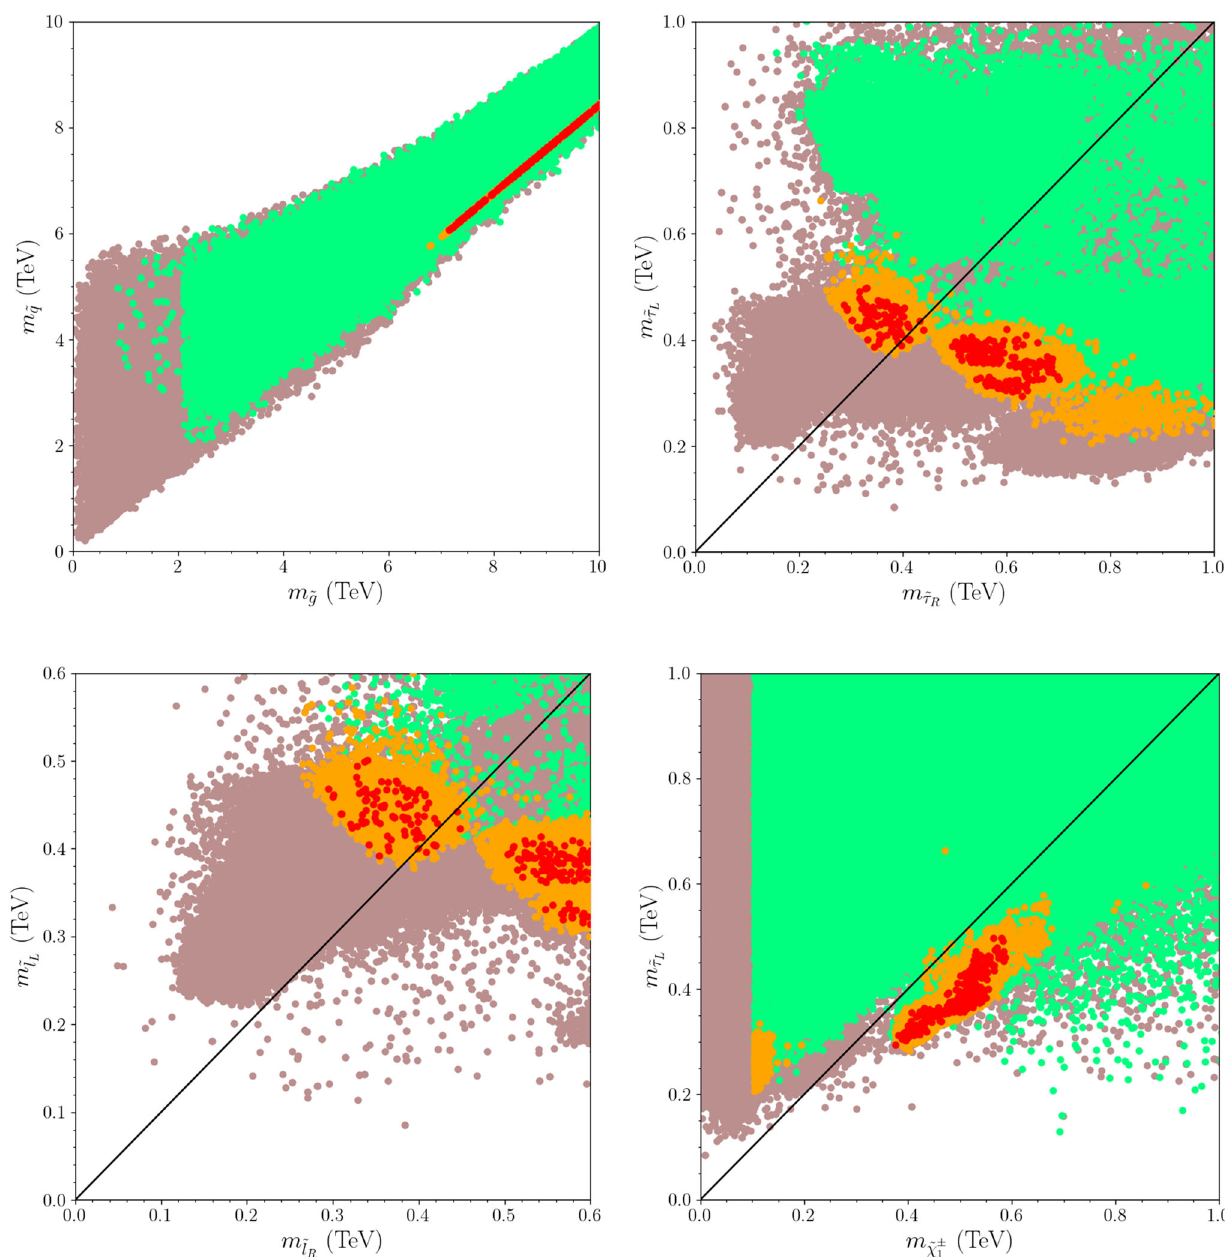
− m ˜ τ − m ˜ μ − m Fig. 7 Sparticle spectrum with plots in the m ˜ q − m ˜ g , m ˜ τ , m ˜ μ and m ˜ τ planes. The color coding is the same as used in ˜ χ ± L R L R L 1 Fig. 6. The diagonal lines represent the degeneracy between the plotted masses − m ticles. The black curve in the m ˜ τ plane displays the and smuons are larger than about 100 GeV, and thus they do ˜ χ 0 1 1 exclusion for the slepton masses with respect to the LSP neu- not play a significant role in coannihilations. The mass dif- tralino masses from the analyses of the slepton pair produc- ferences between the LSP neutralino and staus are expected − m plane shows that tion processes [97]. The main restriction from muon g − 2 to be lower, and the plot in the m ˜ τ ˜ χ 0 1 1 most of the solutions allowed by the Planck measurements is on the smuon masses, and the desired region is realized (cid:2) 440 GeV and m (cid:2) 800 with the correct LSP for m ˜ μ ˜ μ 1 2 (cid:4) m m ˜ τ . The results show that the stau–neutralino relic density (red points), as seen in the top panels of Fig. 8. ˜ χ 0 1 1 However, the mass differences between the LSP neutralino